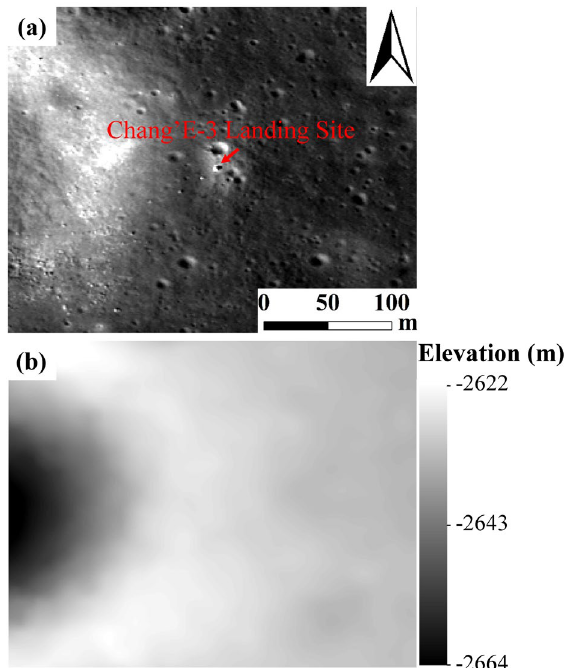
Figure 3 . The test data in the Chang’E-3 landing site, (a) the input image, (a) the input